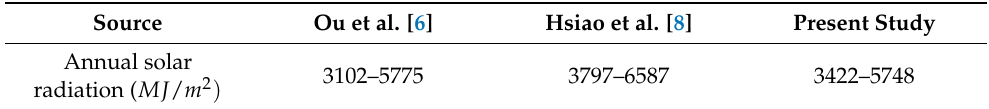
Table 6. Comparison of the range for the estimated annual solar radiation in Taiwan from differ- ent